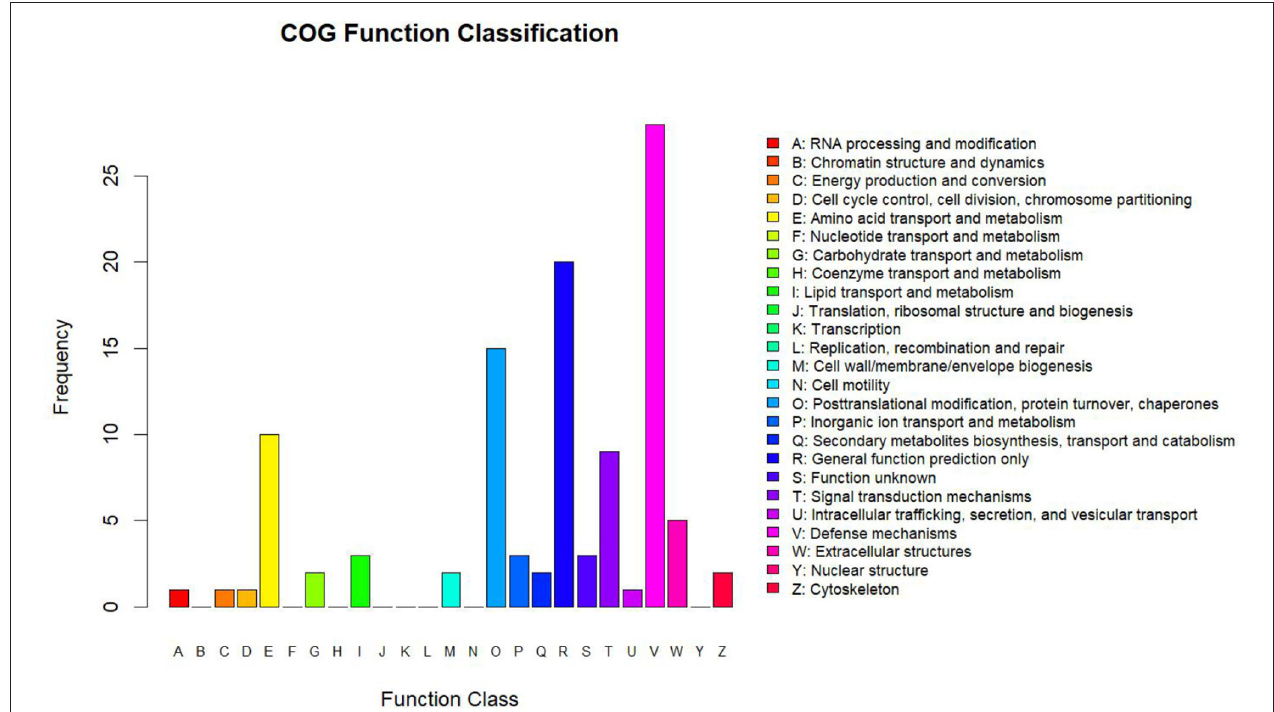
FIGURE 4 | Statistics of COG function classification. The abscissa shows the COG function classification, and the ordinate shows the number of proteins by functional